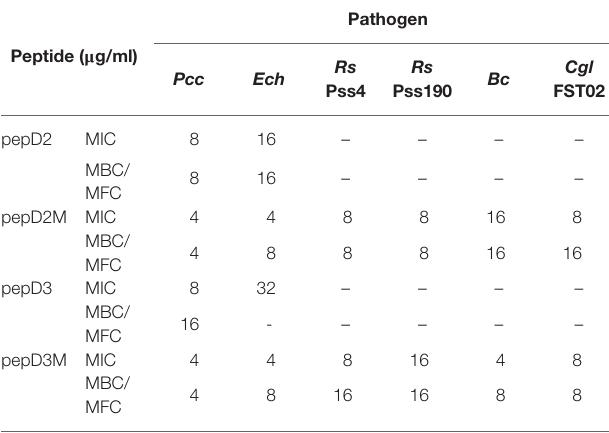
TABLE 5 | MICs and MBCs/minimal fungicidal concentrations (MFCs) of pepD2, pepD3, and the corresponding myristylated peptide variants against phytopathogenic bacteria and fungi in minimal